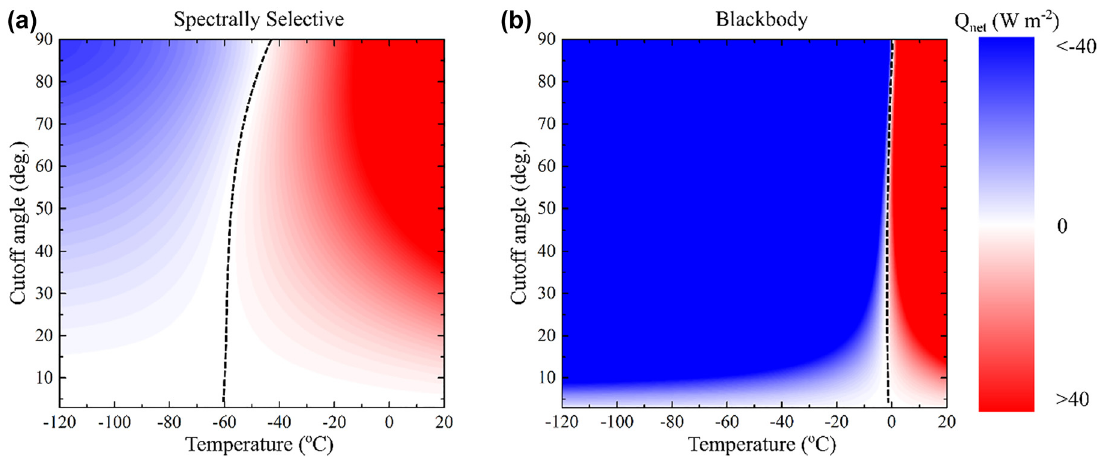
Figure 2: Effect of angular selectivity on the steady state temperature of (a) a spectrally selective thermal emitter, and (b) a blackbody = 0 where the corresponding temperature is the equilibrium temperature of the emitter. emitter. The dashed line traces the values of Q net Angular selectivity plays little role in minimizing the blackbody emitter